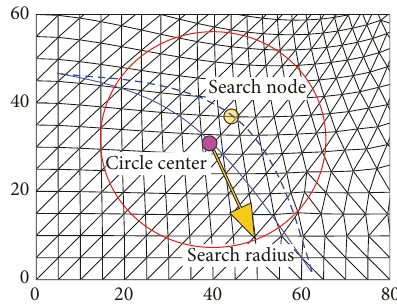
Figure 4: Schematic diagram of the local search method (red circular area for the search range, pink point for the circle center, yellow point for the search node, yellow arrow for the search radius, blue solid line for the contour line of an oil slick in the previous moment, and blue dashed line for the contour line of an oil slick in the present